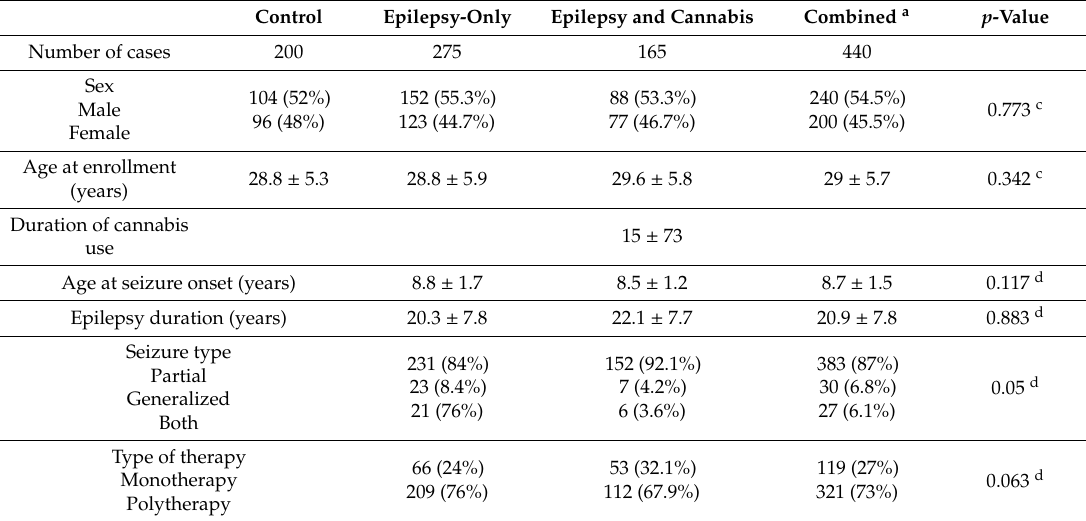
Table 1. Demographic data and clinical characteristics of the study participants ( n =